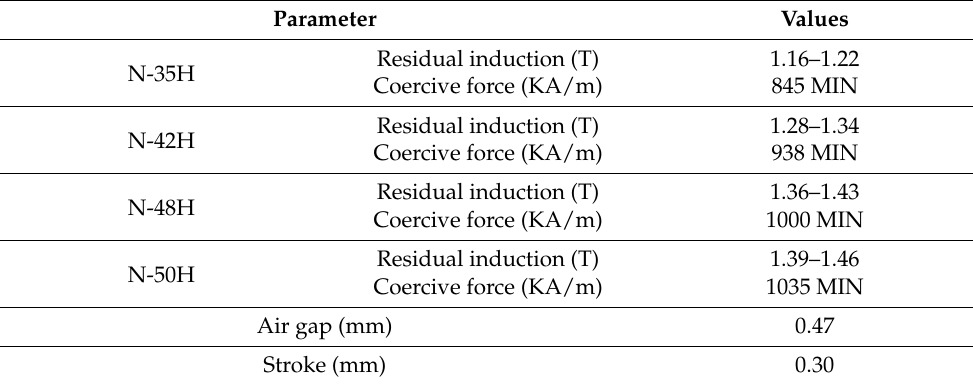
Table 2. Design parameters of the permanent magnet.